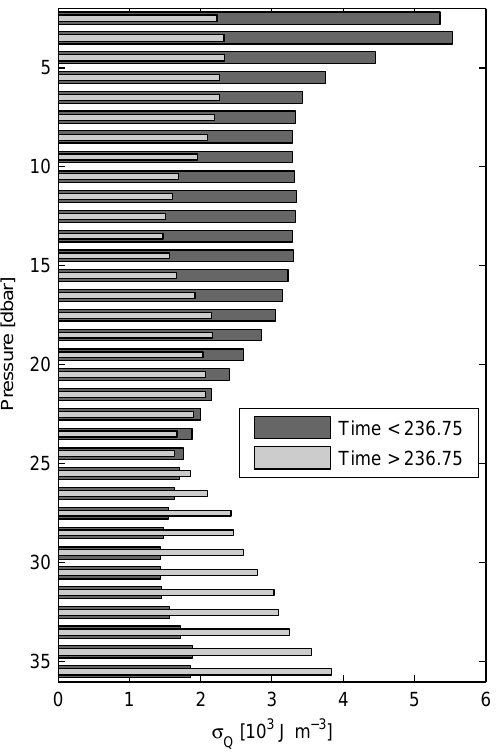
Fig. 13. Average standard deviation of heat content in depth bins for the periods before and after doy 236.75.